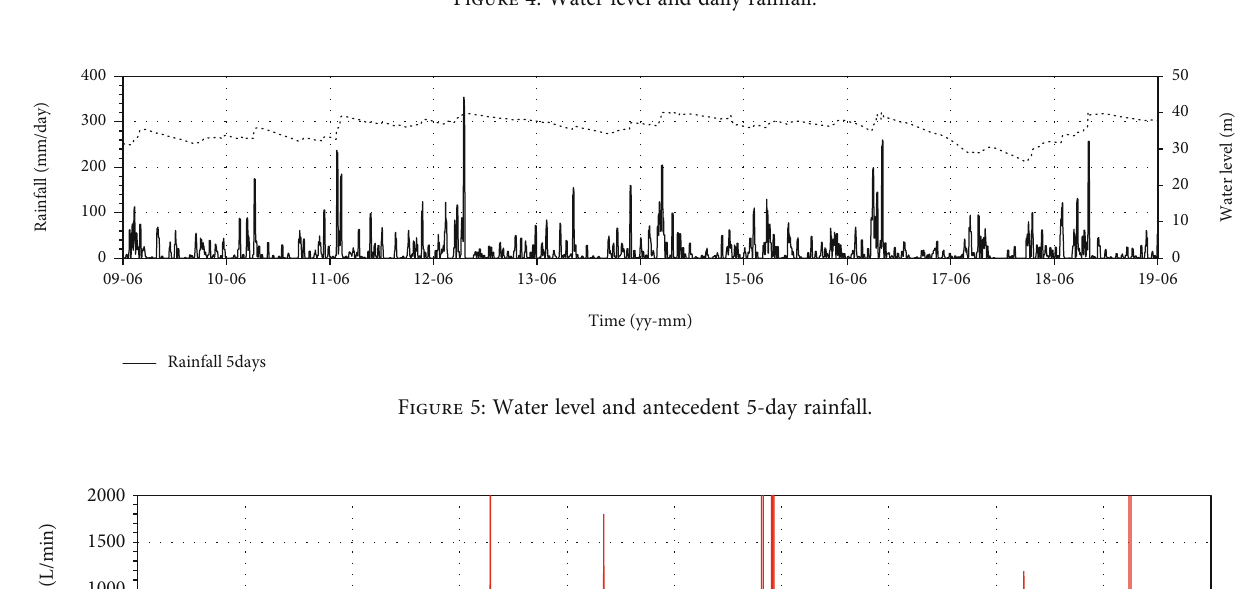
Figure 4: Water level and daily rainfall.